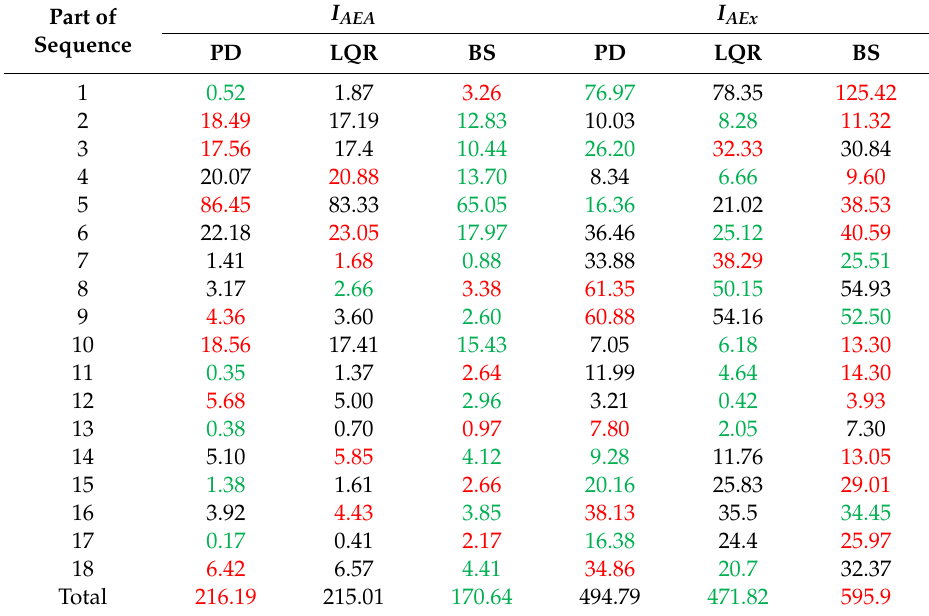
Table A1. Quality indicators of controllers’ performance: Integral of total absolute errors and total absolute desired torque produced during sequence (PD—PD controller, LQR—LQR controller, BC—backstepping controller). PD LQR 1950.63 1635.40 Table A2. Quality indicators of controllers’ performance: Integral of scalar part of absolute quaternion error I AEA and the vector part of the absolute quaternion error related to x axis I AEx (PD—PD controller, LQR—LQR controller, BS—backstepping